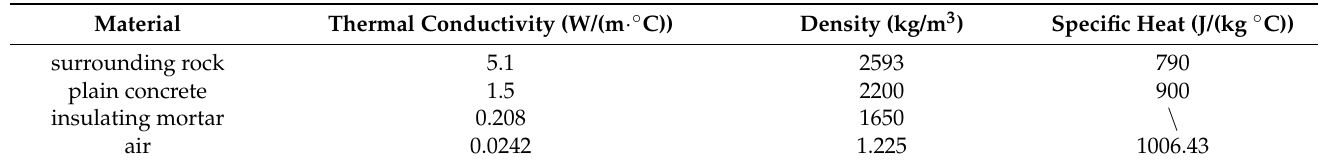
Table 4. Thermophysical parameters of the surrounding rock, the support and the